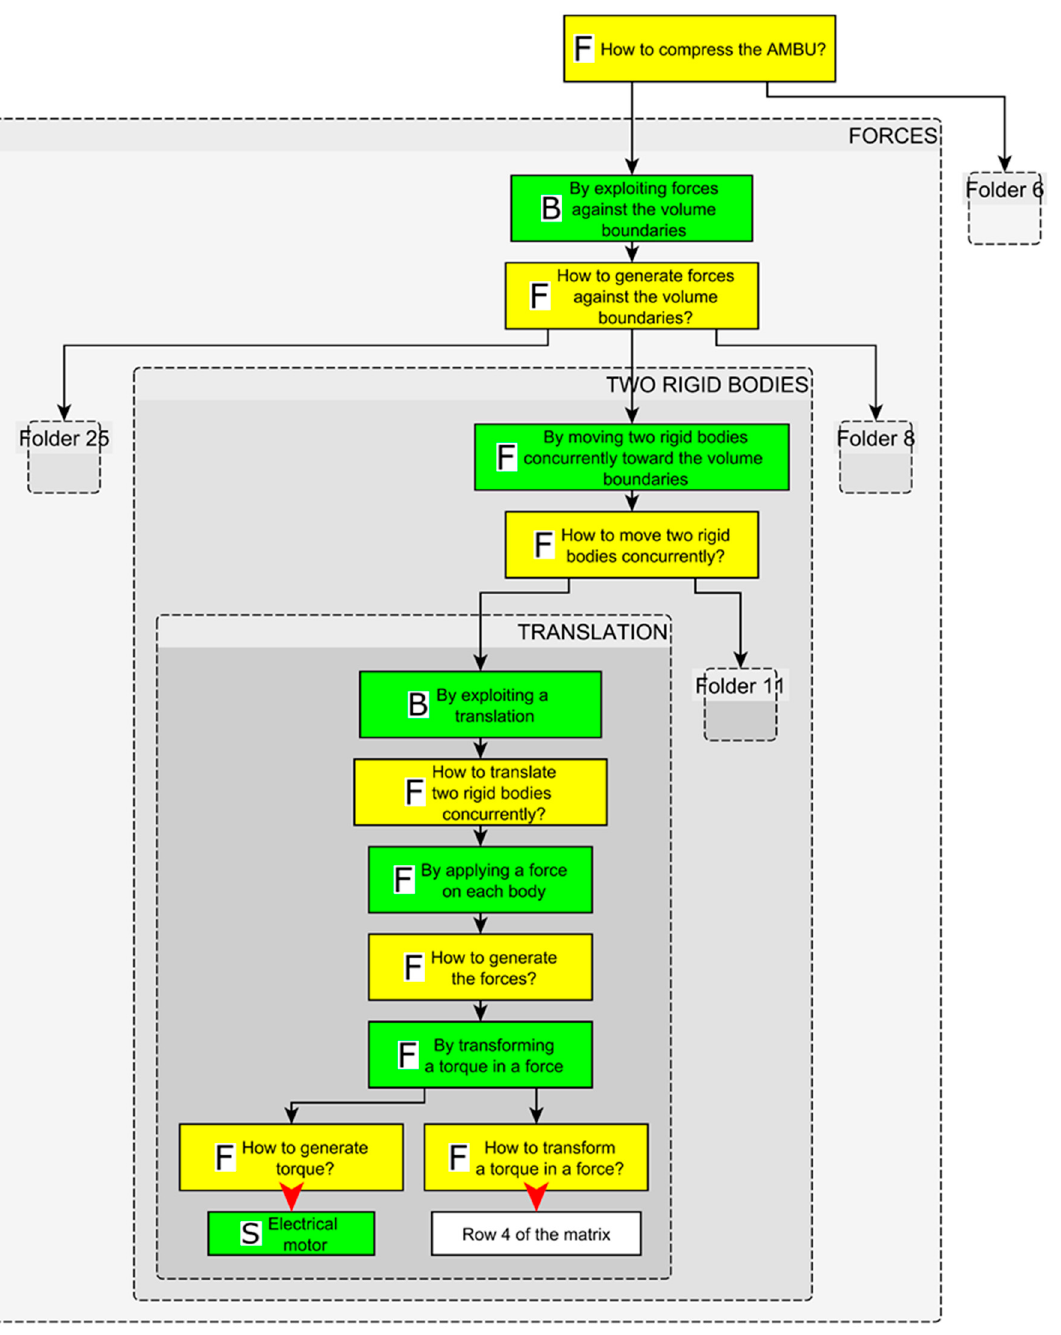
Figure 8. PSN branches that inspired the firm in the design of the new ventilator. For a full-scale view, please see the freely available dataset [71].